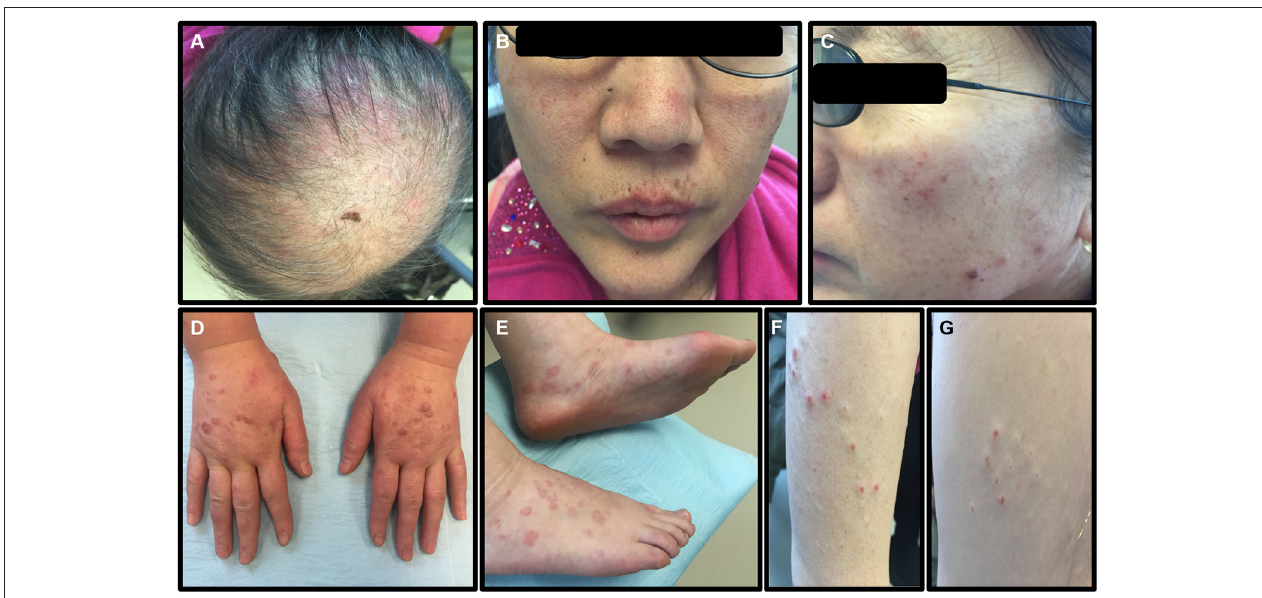
FIGURE 1 | The symptoms of the patient before treatment. (A) Large alopecia patches on the top of the scalp. (B,C) Erythematous plaques on the scalp and face, with irregular edges and slight scales on the surface. (D,E) Violaceous lichenoid papules and blisters can be seen on the back of hands and feet, with clear boundaries. (F,G) Papules could be seen on the trunk and